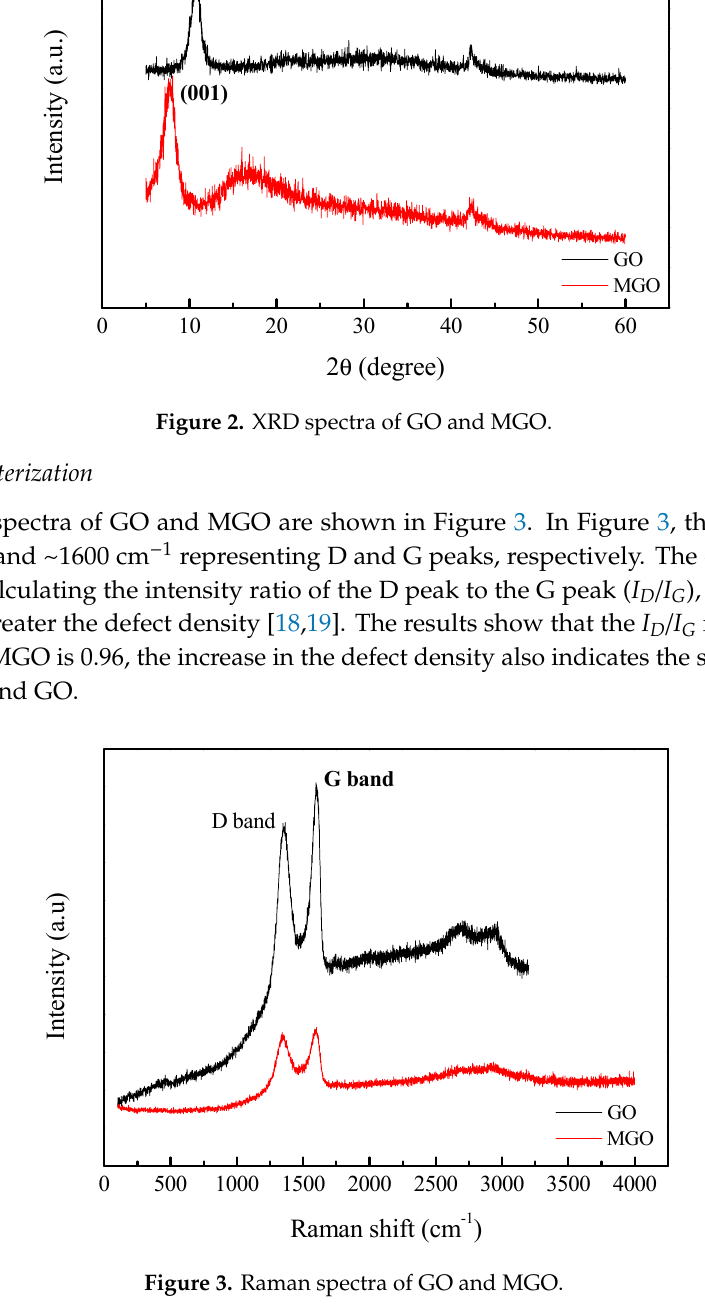
Figure 3. Raman spectra of GO and MGO.